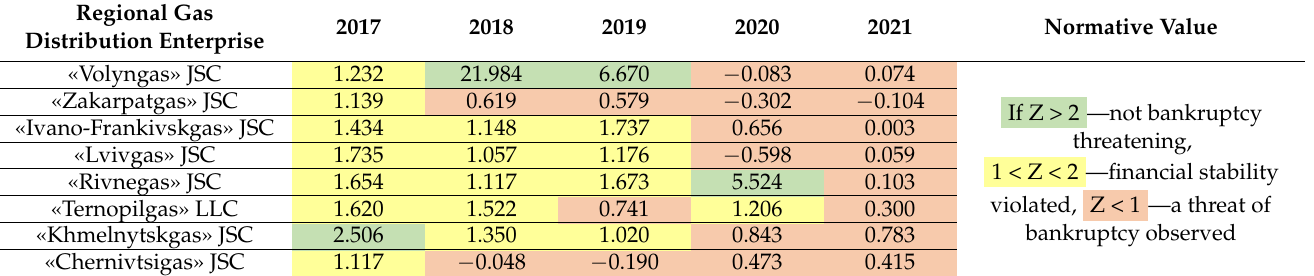
Table 10. Matviychuk’s model approbation.